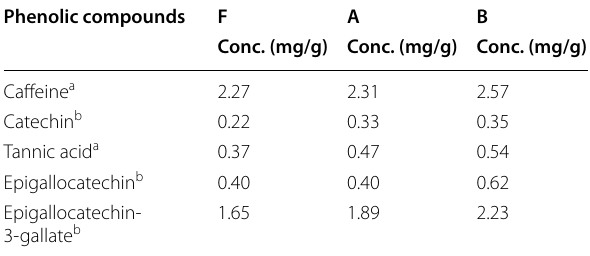
Table 8 Identification and quantification of phenolics using